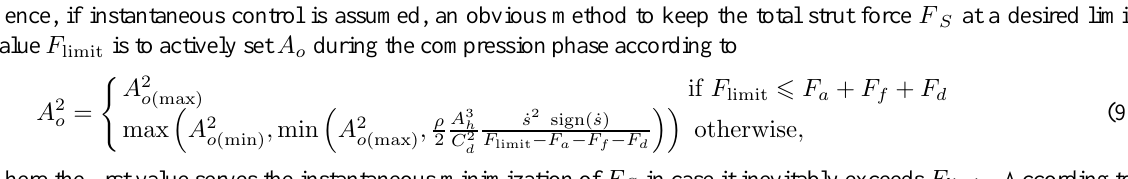
Fig. 9. VD-SLG compared to PLG, relative improvement: Computed ratio of the peak strut forces in the optimally controlled VD-SLG and PLG at the same landing conditions, in dependence on the total mass m and sinking velocity v 0